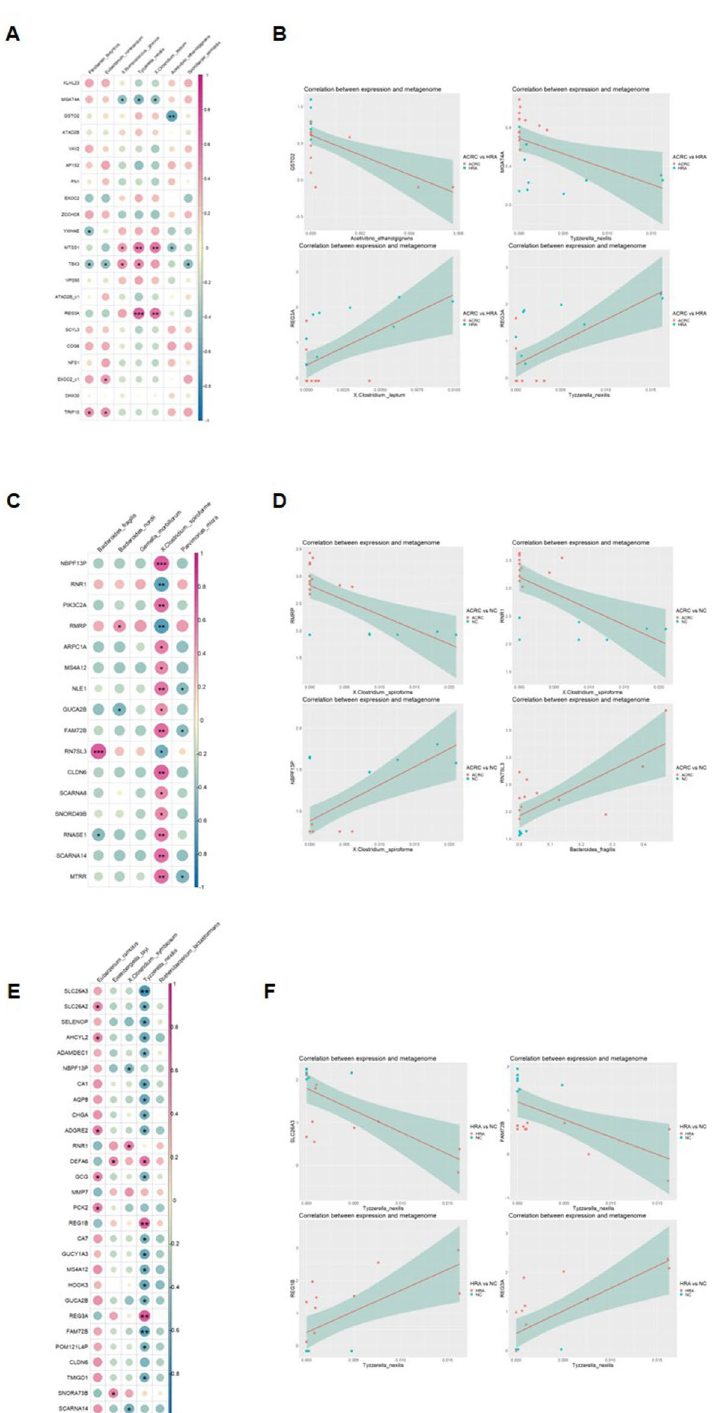
Figure 3. Correlation between RNA sequencing and metagenome results. ( A ) Correlation plots and ( B ) scatter plots comparing ACRC and HRA samples. ( C ) Correlation plots and ( D ) scatter plots comparing ACRC and NC samples. ( E ) Correlation plots and ( F ) scatter plots comparing HRA and NC samples. In correlation plots, color indicates correlation coefficients, and circle size indicates statistical significances. Only correlation coefficients with p-values < 0.05 are shown. The two analysis results with the highest positive and negative correlation coefficients are presented as scatter plots and regression lines. p -values of each correlation analysis are indicated in the correlation plots (* p < 0.05, ** p < 0.01, *** p < 0.001). ACRC advanced colorectal cancer, HRA high-risk adenoma, NC normal